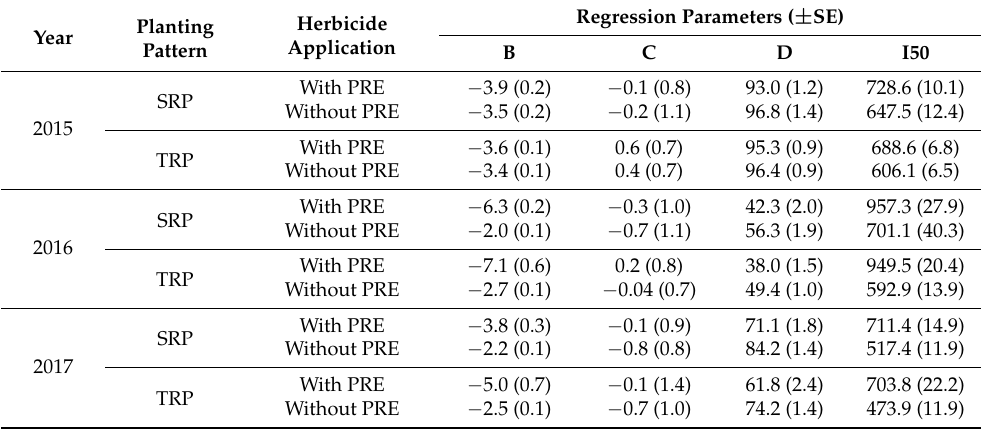
Table 5. Corn yield loss (%) in response to increasing duration of weed interference represented by growing degree days (GDD after emergence) at two patterns of planting (SRP and TRP) with two levels of herbicide application in corn grown without PRE herbicide and with PRE herbicide during 2015, 2016, and 2017, in field experiments conducted in Padina, South Banat District, Serbia. Regression parameters represent a four-parameter log-logistic model.